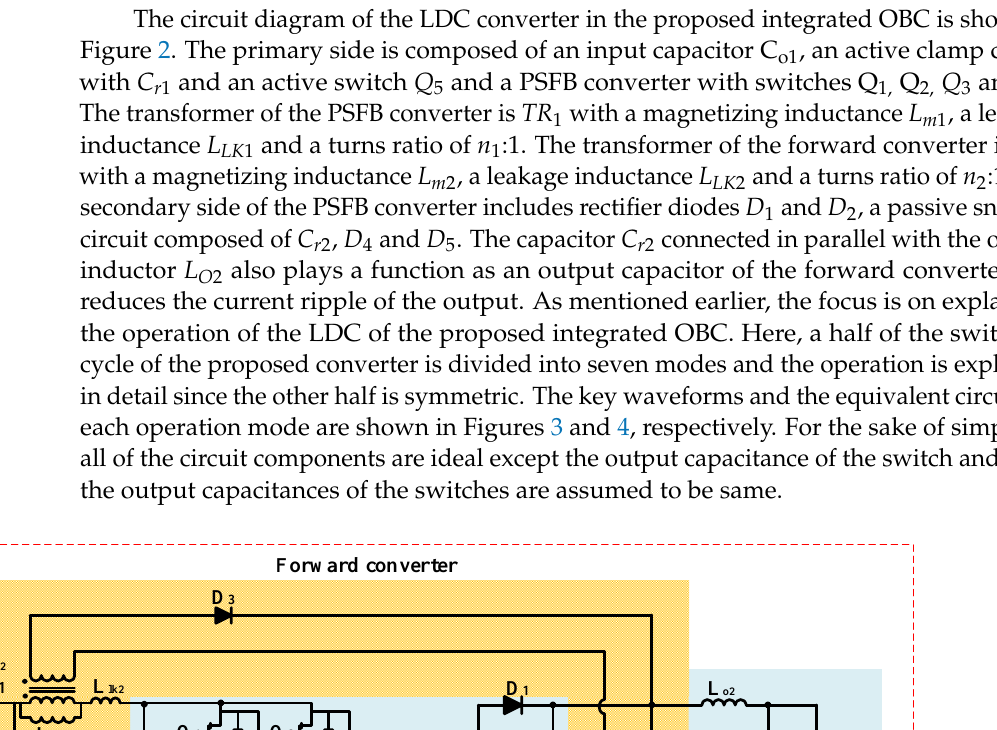
Figure 3. Key waveforms of proposed LDC converter.